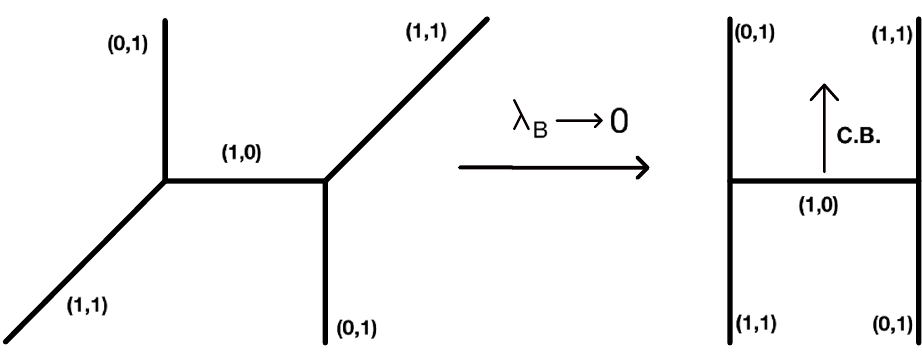
Figure 6 . Branes don’t bend at (cid:21) B = 0. A U(1) photon becomes dynamical. The Coulomb Branch is represented by moving the D5-segment up and